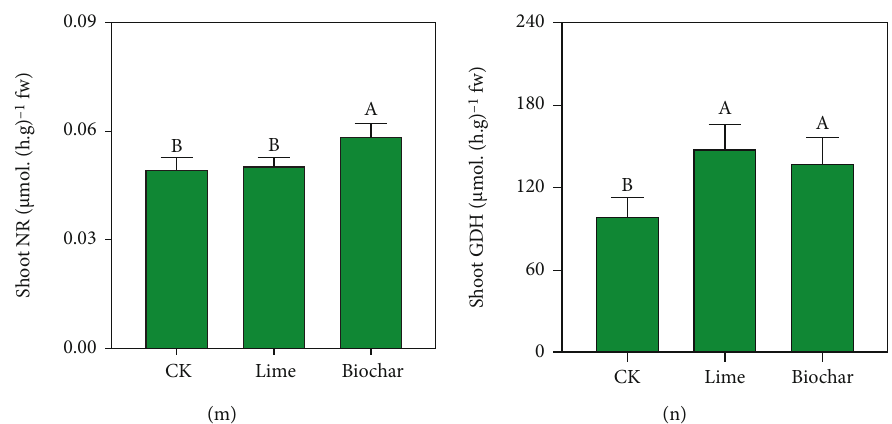
Figure 2: Responses of B. napus physiological characteristics under three treatments. B. napus : Brassica napus L. ; ISP: ion-bound pectin; O : hydrogen peroxide; O 2- · : superoxide anion; SOD: superoxide dismutase; CSP: covalently bound pectin; MDA: malondialdehyde; H 2 2 CAT: catalase; POD: peroxidase; NO 3- : nitrate; NR: nitrate reductase; GDH, and glutamate dehydrogenase. Means ± SD ( n = 4 ). Di ff erent lowercase letters indicate signi fi cant di ff erences ( P < 0 : 05 ) between the three